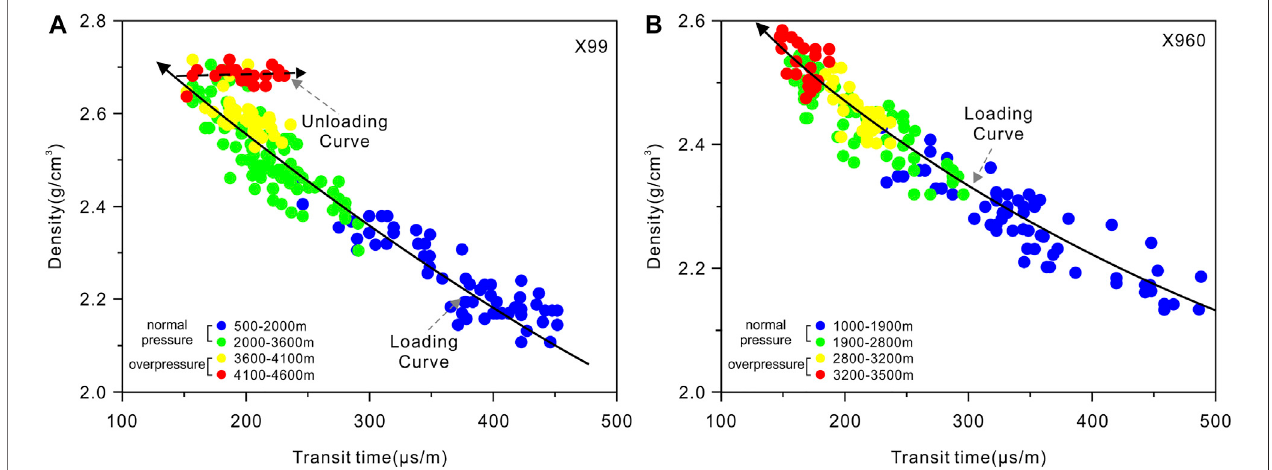
FIGURE 11 | Sonic transit time versus density cross plots for well (A) X99 and well (B) X960 in the Linnan Sag. The well locations are shown in Figure 1 .